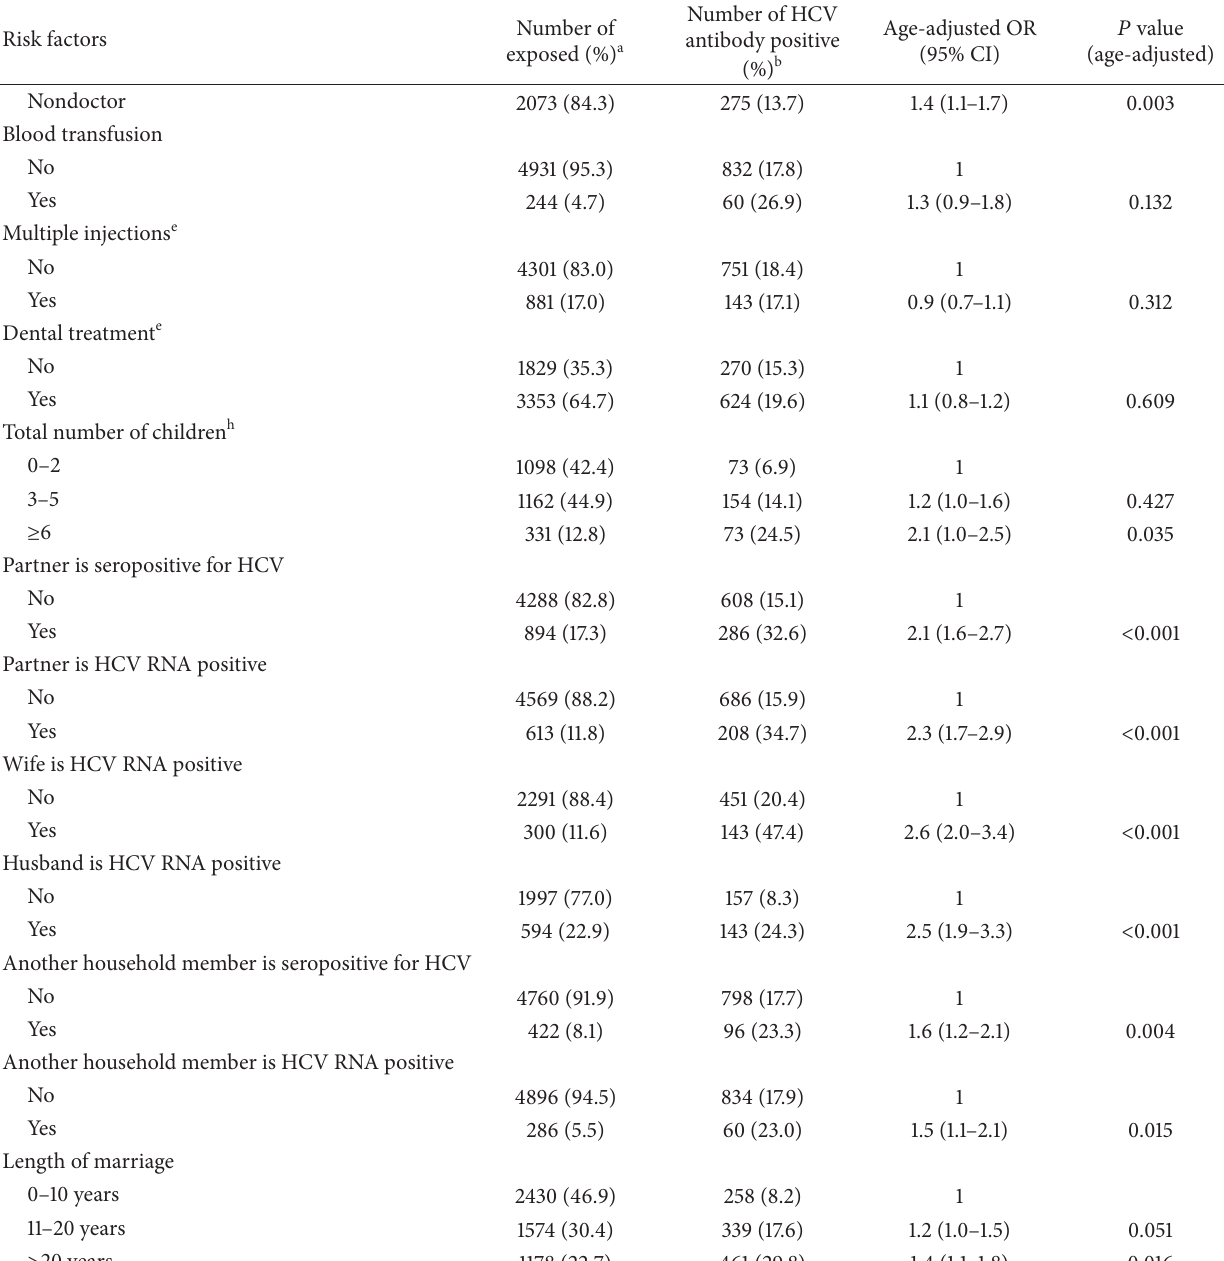
FGC: female genital cutting. a Unweighted